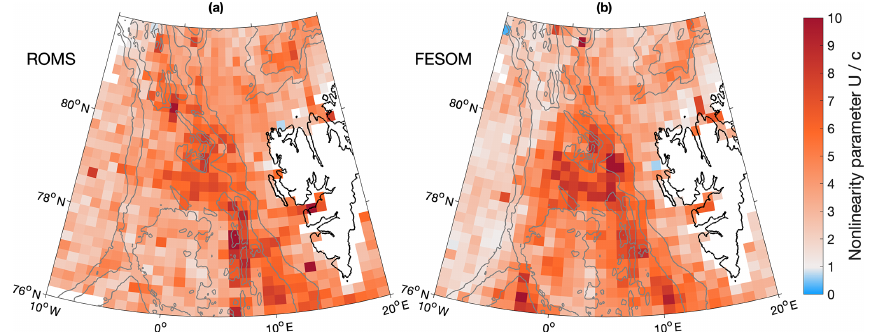
Figure 11. Maps of averaged nonlinearity parameter U/c , where U and c are maximum rotational and translation speeds, respectively, for eddies detected between 2006 and 2009 in (a) ROMS and (b) FESOM. Values of U/c were averaged on a 1 ◦ longitude × 0.2 ◦ latitude grid. Grey contours show bathymetry contours at 1000m